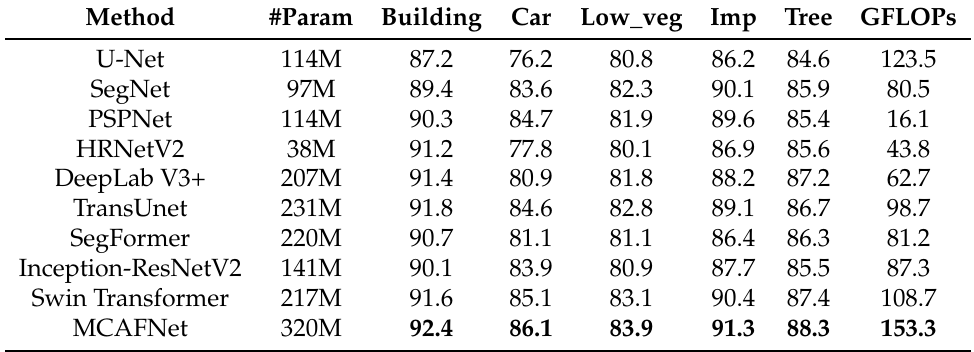
Table 4. Performance of ground objects interpreted by the different models on the Potsdam